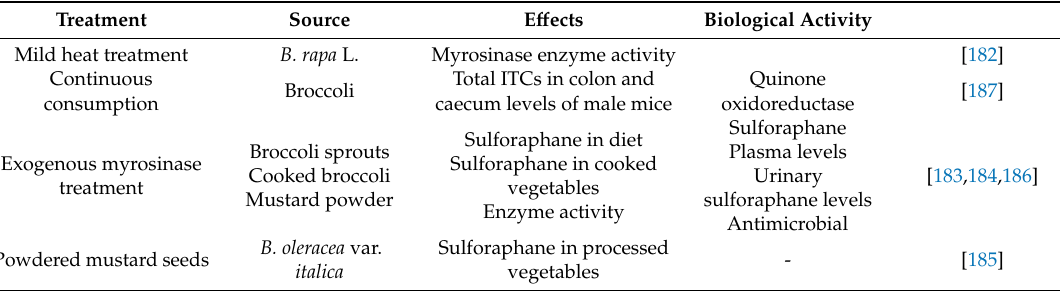
Table 4. Improving GSs / GSHPs bioavailability and